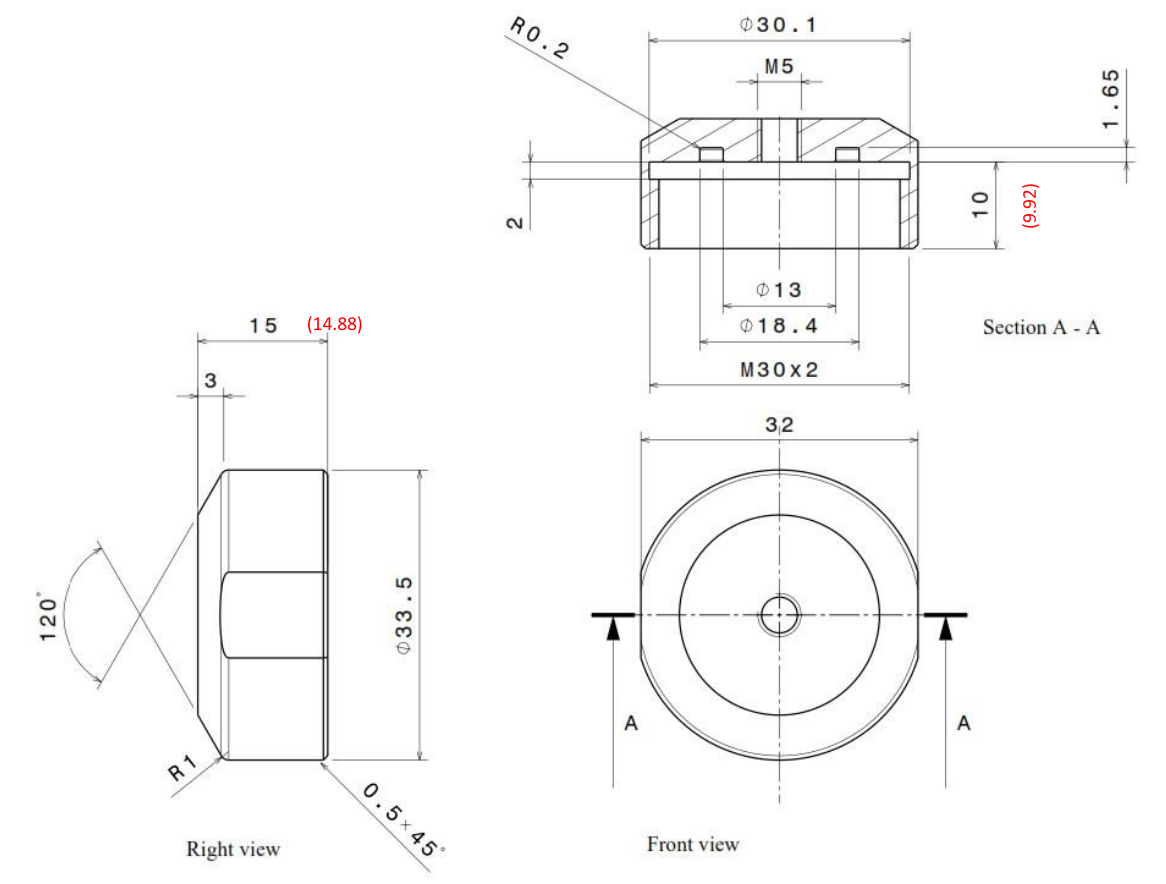
Figure A3. Mechanical drawing of the inlet flange. Parentheses (red) indicate the measured dimen- sions of the sample.